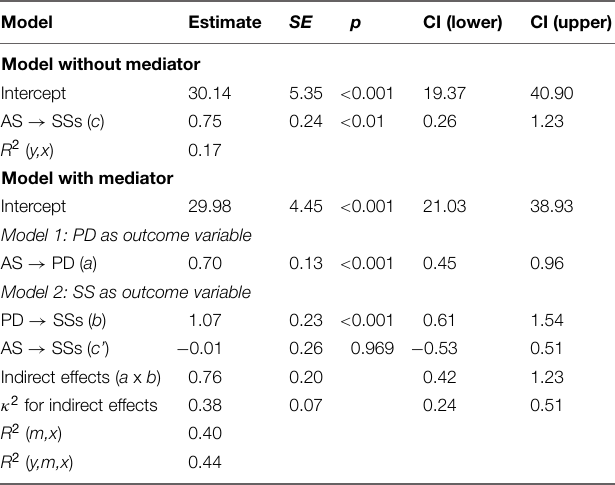
TABLE 2 | Parameter estimates of the model examining the mediating role of psychological distress in the relationship between anticipated stigma and somatic symptoms.